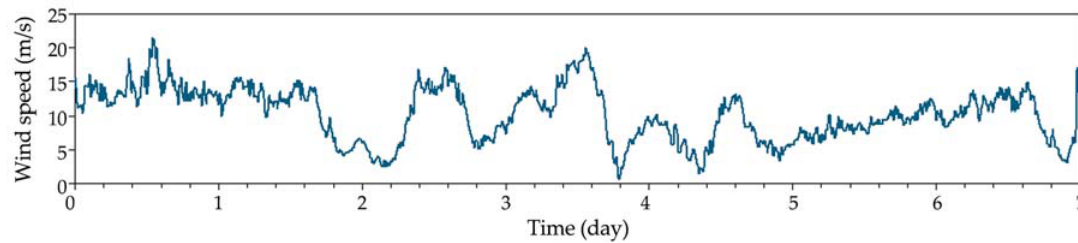
Figure 7. The input wind speed over one week time range.